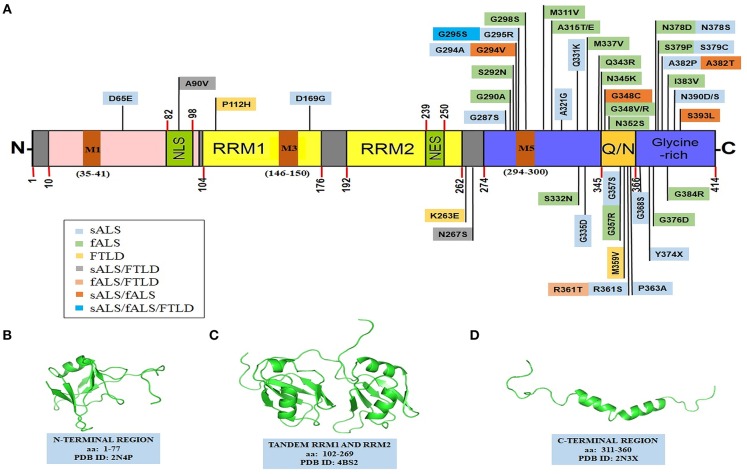
Structural features of TDP-43. (A) TDP-43's domain organization depicting ALS and FTLD-linked mutations. TDP-43 comprises of an NTD domain, two RRM domains, a nuclear export signal (NES), a nuclear localization signal (NLS), a prion-like disordered C-terminal domain (with glutamine/asparagine-rich (Q/N) and Glycine-rich regions) and mitochondrial localization motifs (M1−35–41; M3−146–150; M5−294–300). Sporadic mutations and familial gene mutations generating amino acid substitutions in TDP-43 are classified. Several TDP-43 mutations overlap between ALS and FTLD as well as between sALS and fALS (Baumer et al., 2009; Xiong et al., 2010; Fujita et al., 2011; Janssens et al., 2011; Budini et al., 2012; Chiang et al., 2012; Cruts et al., 2012; Lattante et al., 2013; Moreno et al., 2015). PDB structures of: (B) N-terminal region (PDB id-2N4P); (C) a tandem RRM1 and RRM2 segment (PDB id-4BS2); (D) a C-terminal region (aa: 311–360) (PDB id-2N3X). Structures in the (B–D), have been adapted with permissions respectively from: John Wiley and Sons (Mompeán et al., 2016b); Springer Nature (Lukavsky et al., 2013); and Springer Nature (Jiang et al., 2016, creative commons attribution 4.0 license). fALS, familial amyotrophic lateral sclerosis; NES, nuclear export signal; NLS, nuclear localization signal; NTD, N-terminal domain; Q/N, glutamine/asparagine; RRM, RNA recognition motif; sALS, sporadic amyotrophic lateral sclerosis; TDP-43, TAR DNA binding protein 43.